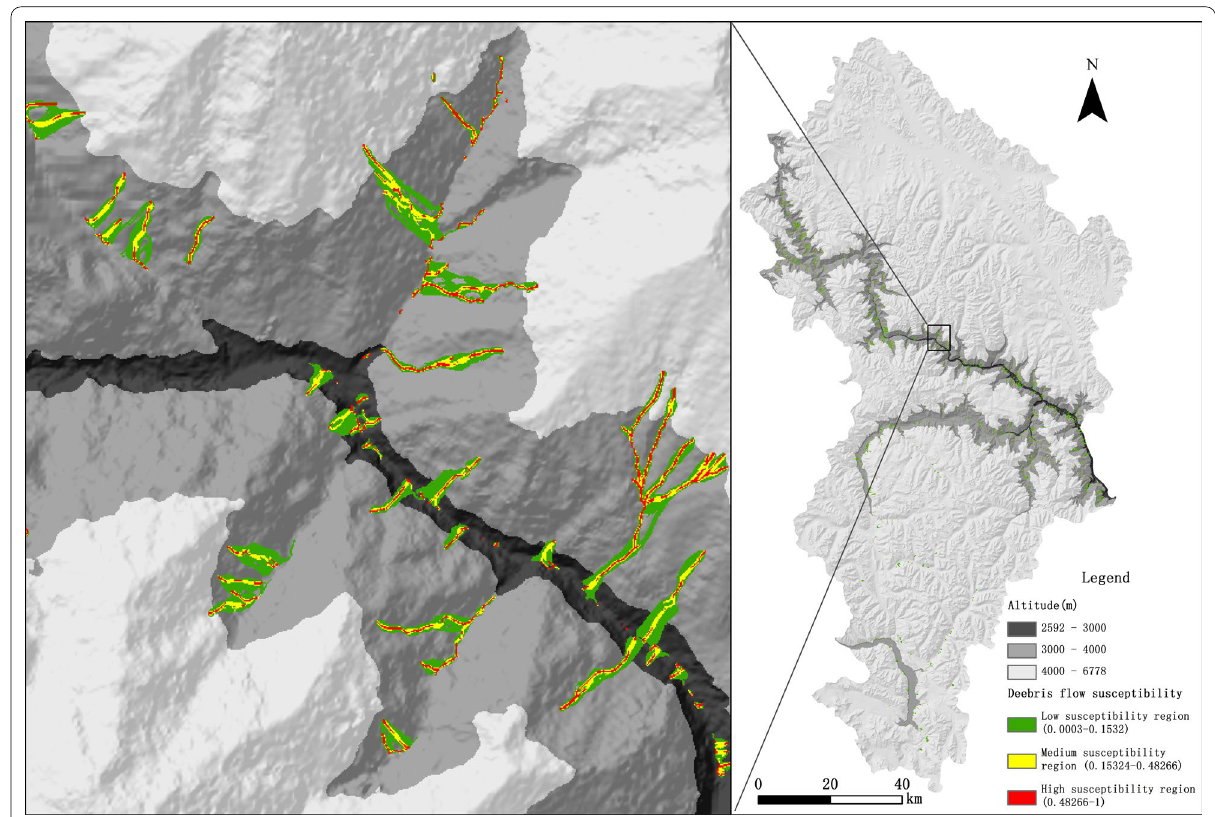
Fig. 9 Debris flow susceptibility classes and altitude ranges in Basu